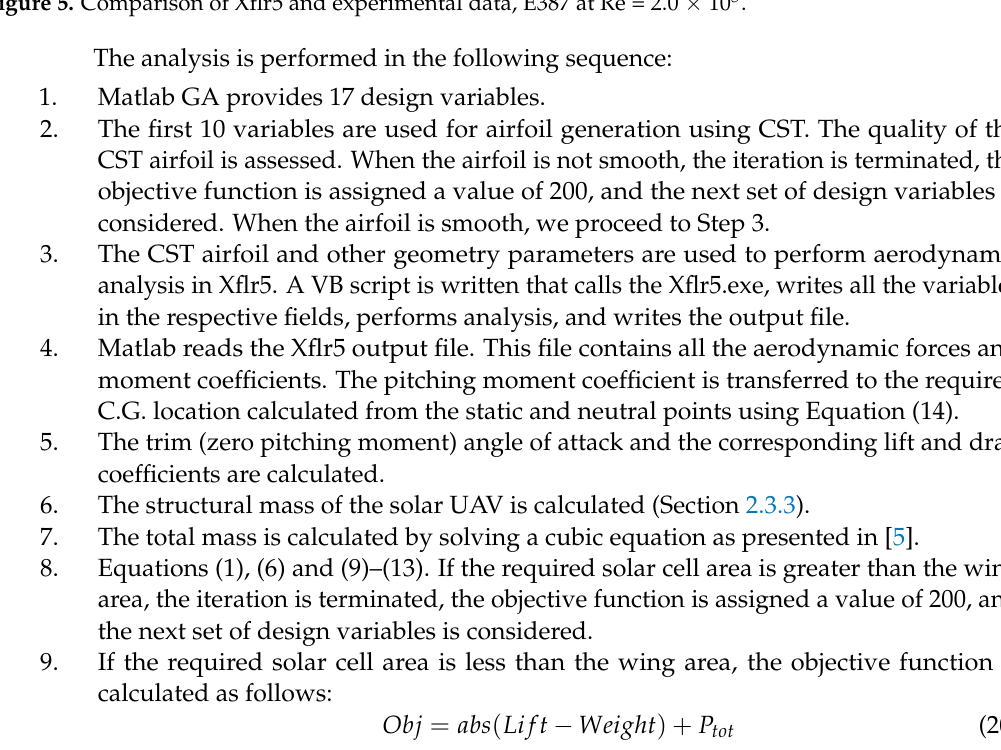
Figure 5. Comparison of Xflr5 and experimental data, E387 at Re = 2.0 × 10 5 .